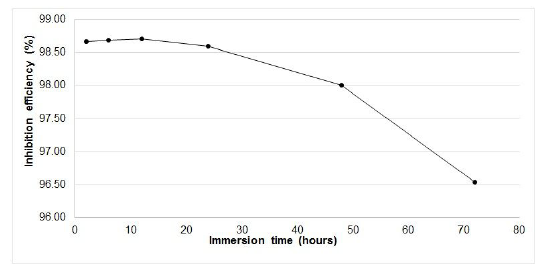
Figure 13. Corrosion inhibition efficiency at different immersion times in 0.5 mol L -1 HCl